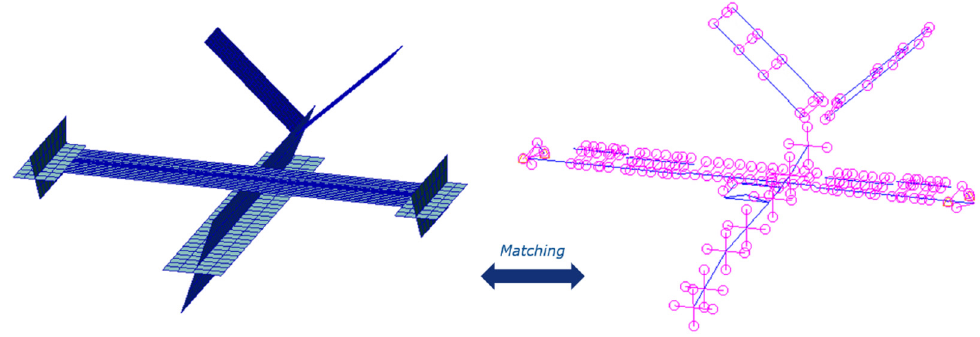
Figure 2. Aeroelastic model.